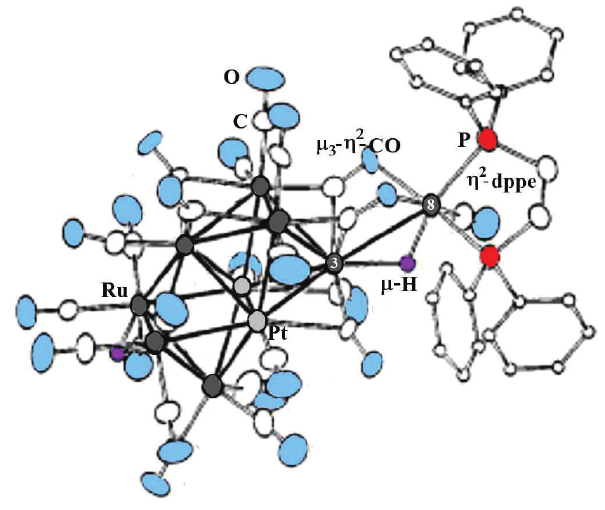
Ru (µ -η 2 -(CO) 2 8 3